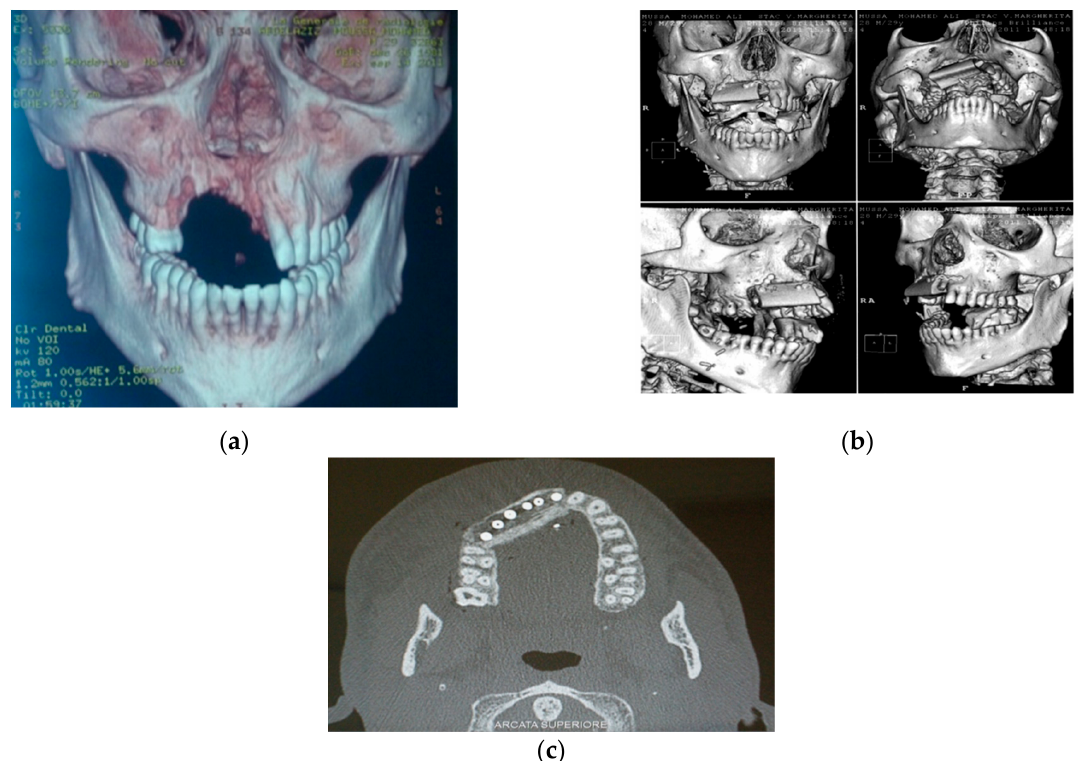
Figure 5. ( a )CT scan before reconstruction surgery and prosthetic rehabilitation; ( b ) 3D CT scan after reconstruction surgery with osteomyocutaneous free fibula flap; ( c ) CT scan after placement of six implants.